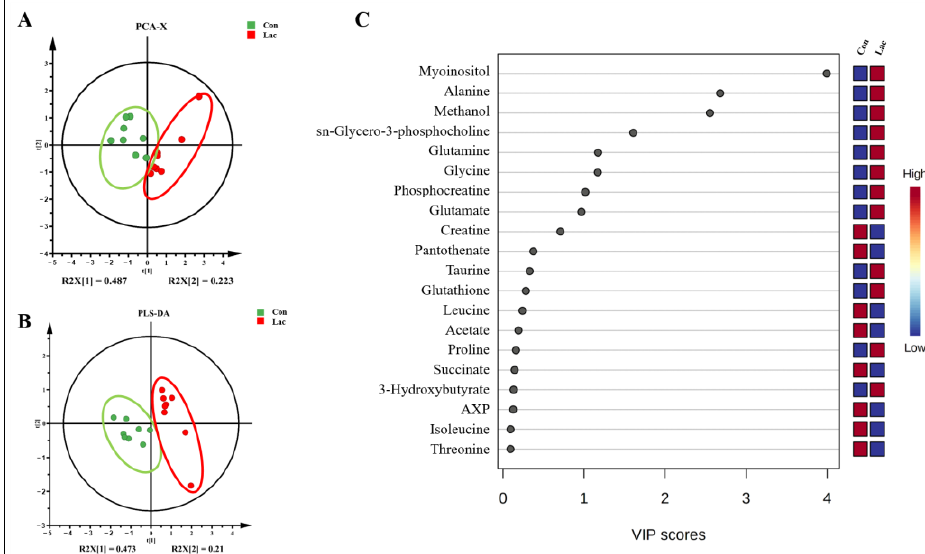
Figure 5. Multivariate statistical analysis for the NMR data of the two groups of myoblasts. ( A ) PCA scores plot for the non-supervised multivariate statistical analysis of Lac and Con; ( B ) PLS-DA scores plot for the supervised multivariate statistical analysis of Lac vs. Con; and ( C ) VIP scores-ranking plot of significant metabolites screened from the PLS-DA model with the criterion of VIP > 1.